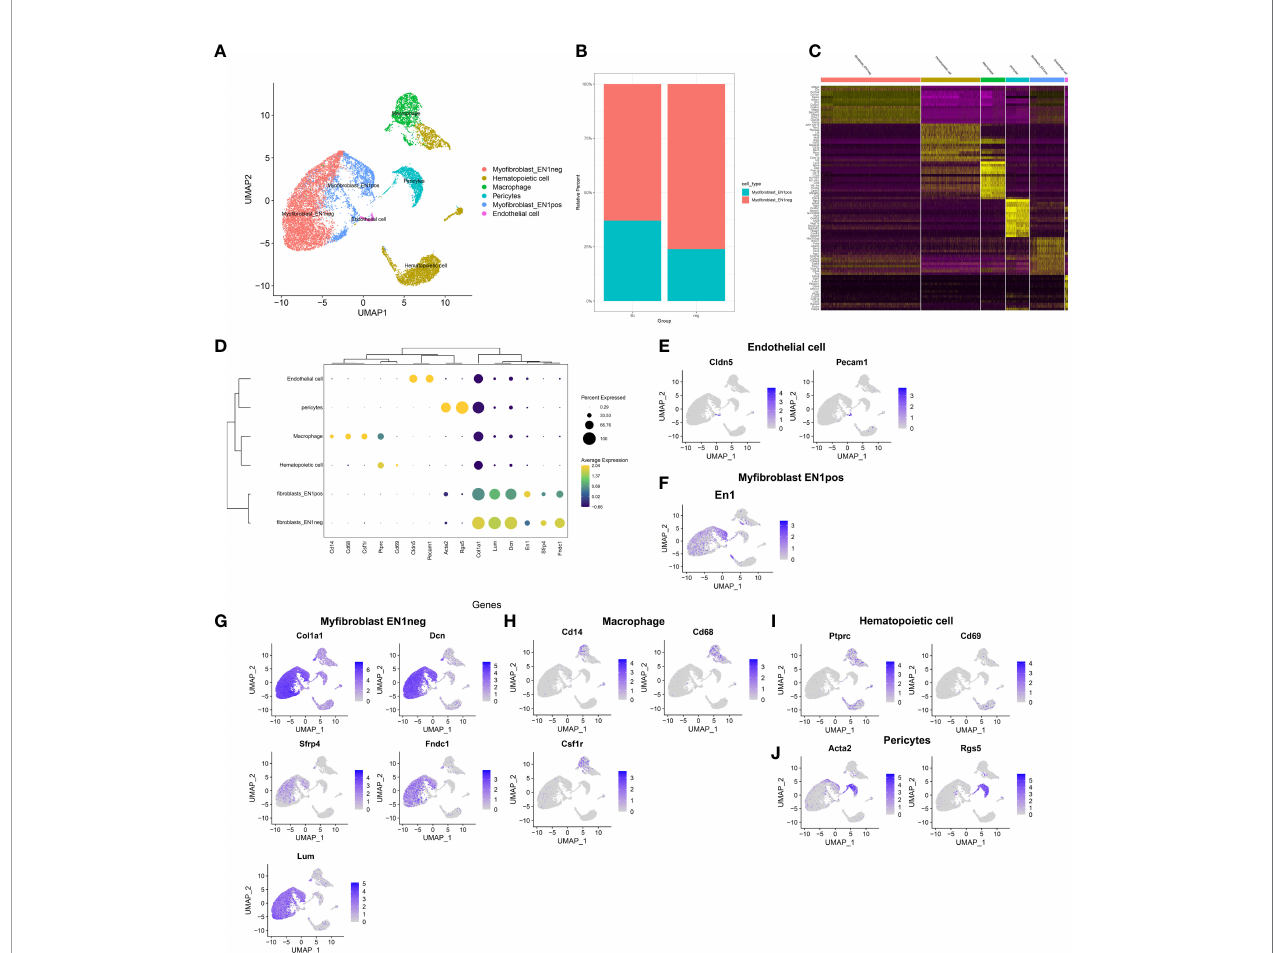
FIGURE 2 | Identi fi cation of cell types and their marker genes across fi brotic and regenerative wound dermal cells. (A) UMAP plots showing cell types identi fi ed by marker genes. Each cell type was colored by a unique color. (B) The cell ratio of EN1-negative and -positive myo fi broblasts among fi brotic and regenerative wound dermal cells. (C) Heatmap visualizing cell-type-speci fi c gene expression patterns. Each column represented the average expression after cells were grouped. (D) Integrated analysis showing marker genes across cell types. The size of each circle re fl ected the percentage of cells in each cell type where the gene was detected, and the color shadow re fl ected the average expression level within each cell type. (E – J) UMAP plots of expression of the marker genes for endothelial cells, EN1-negative and -positive myo fi broblasts, macrophages, hematopoietic cells, and